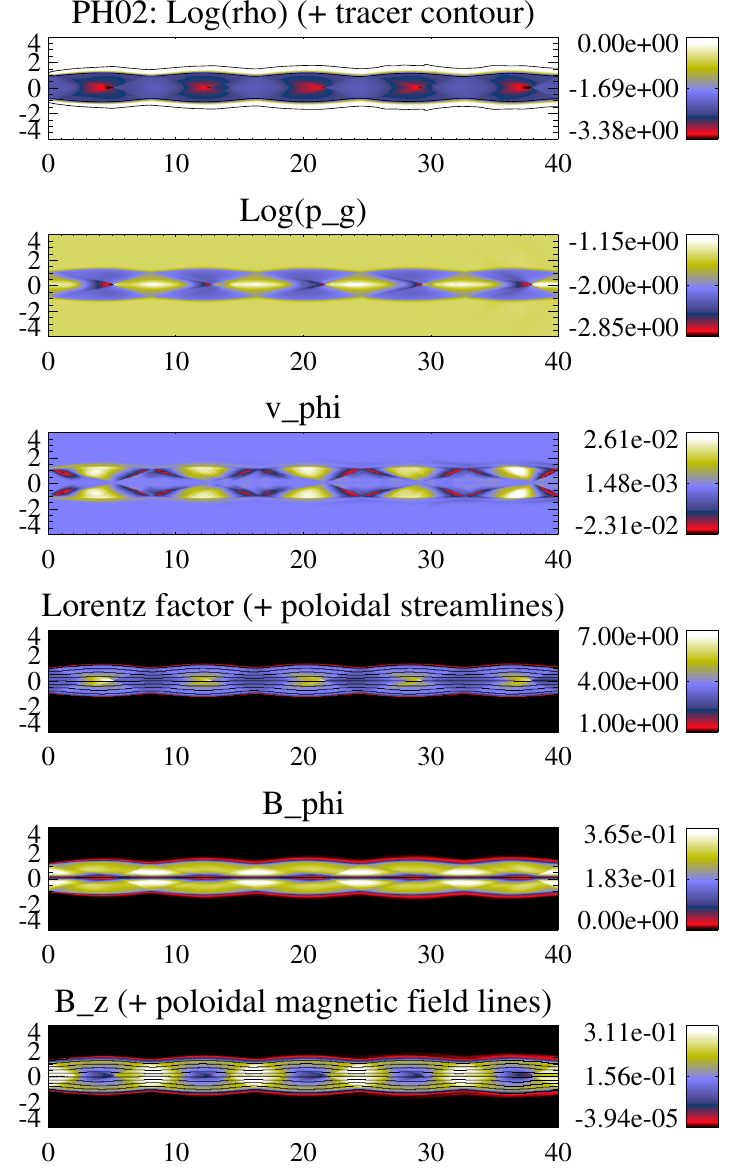
Figure 4. Steady structure of the Poynting-flux-dominated, hot jet PH02. From top to bottom are distributions of rest-mass density, gas pressure, azimuthal flow velocity, flow Lorentz factor, and toroidal and axial magnetic field components once the steady state has been settled. Poloidal flow and magnetic field lines are superimposed onto the Lorentz factor and axial magnetic field panels, respectively. Two contour lines for jet mass fraction values 0.005 and 0.995 are overplotted on the density